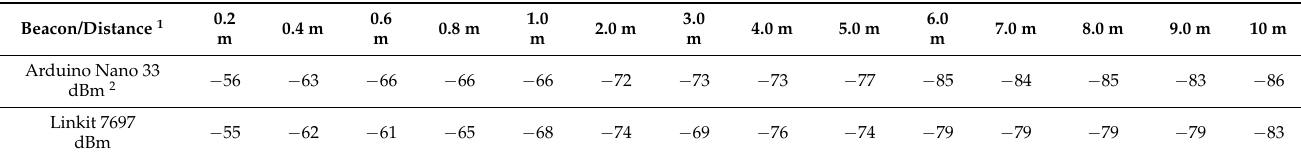
Table 7. RSSI/distance conversion